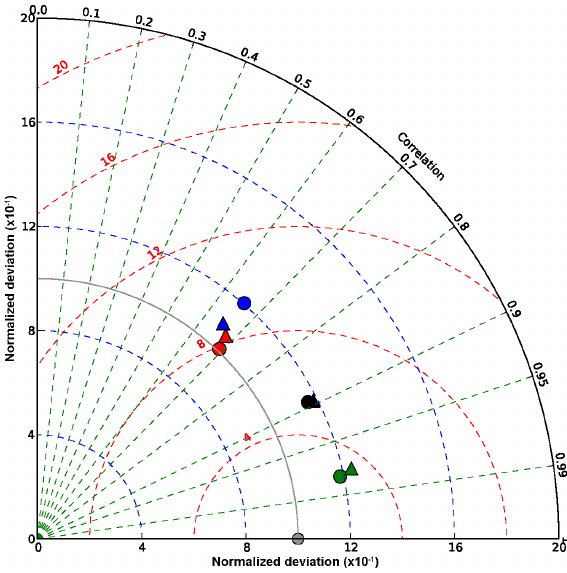
Figure 2. Taylor diagram of the comparison of SL_cci (triangles) and AVISO SSALTO/DUACS DT (circles) merged altimeter sea level products with Argo (900dbar) and GRACE independent mea- surements for the global data (black) and separating high frequen- cies (red), the annual signal (green) and the inter-annual signals